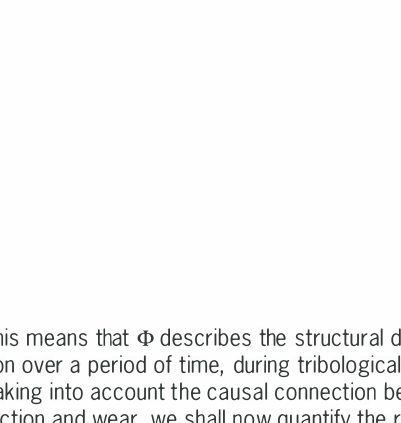
e , ••• in Abhiingigkeit von der Beanspruchszeit fur verschiedene Geschwindigkeitsgefiille [6] Fig. 2: Rheological energy density as a function of loading time for different shear rates